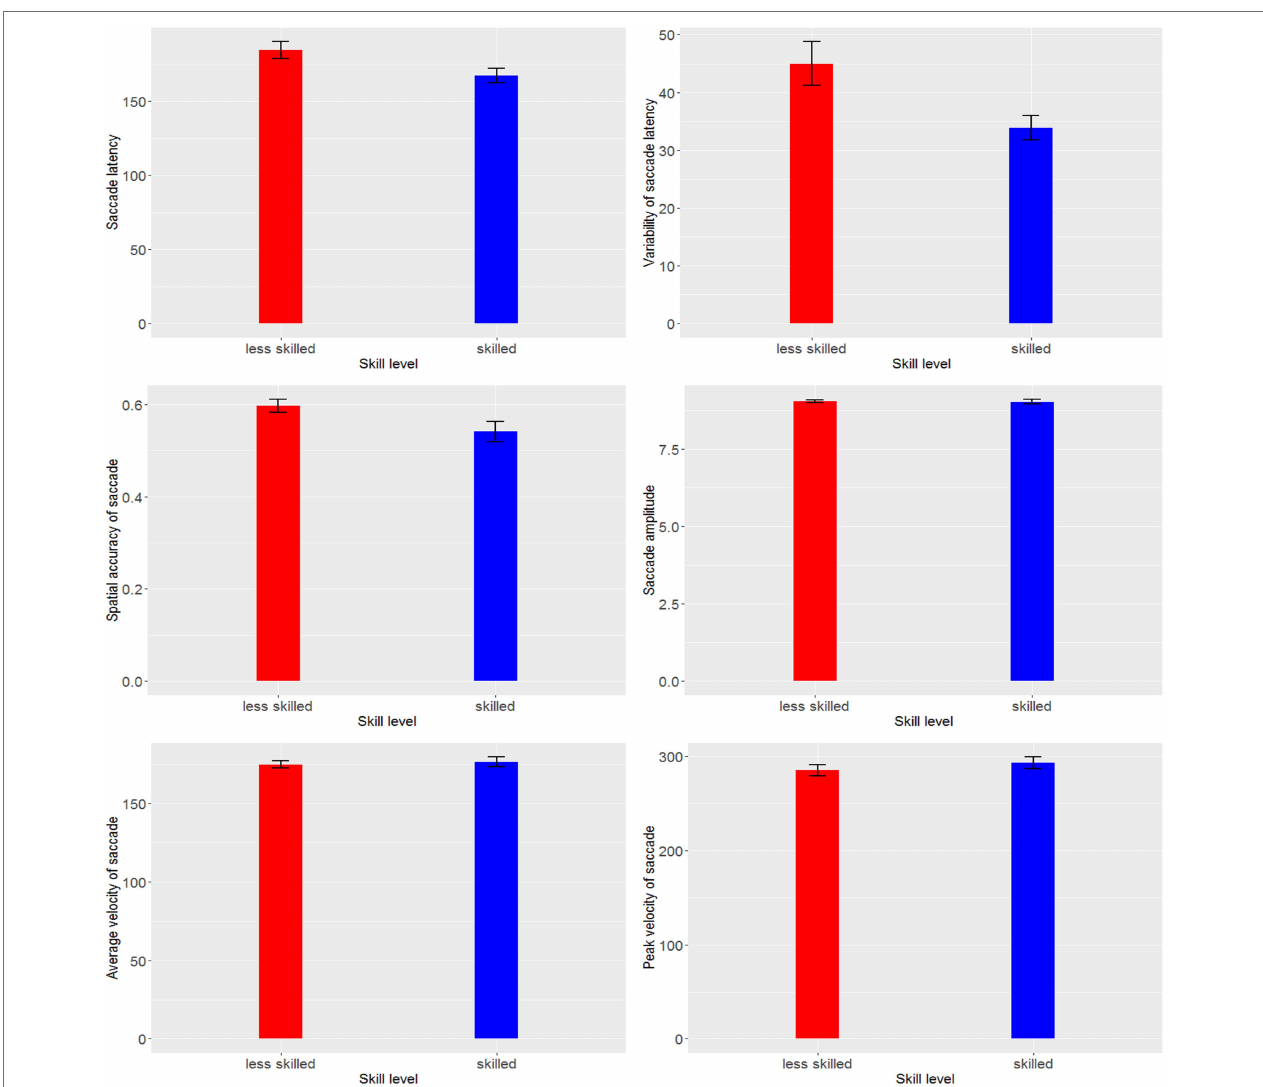
FIGURE 1 | Differences in saccadic eye movement indexes between skill and less skilled